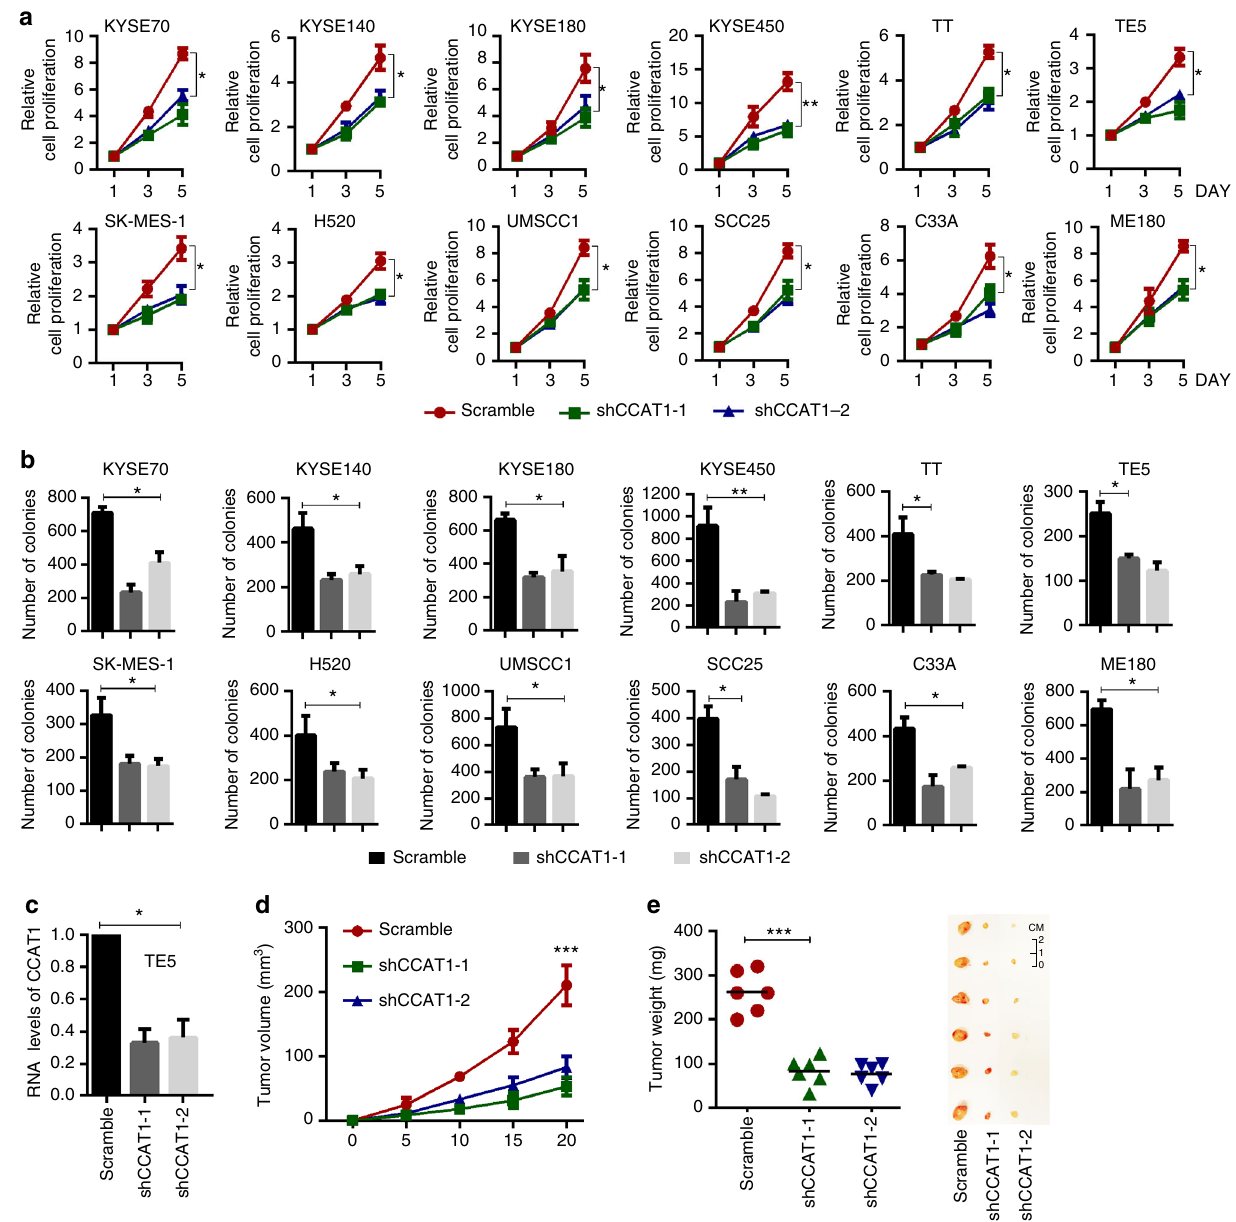
Fig. 3 CCAT1 promotes SCC cell proliferation both in vitro and in vivo. a Cell viability and b Colony formation assays of SCC cell lines upon CCAT1 knockdown with two different shRNA targets. c Relative expression of CCAT1 following silencing of CCAT1 in TE5 cells. Bars of a – c represent mean ± SD of three experimental replicates. * P < 0.05, ** P < 0.01. P values were determined using t -test. d Tumor volumes were measured at the indicated time points in scramble and CCAT1 knockdown xenograft mice. e Left: summary of mean tumor weight measured at end point; Right: images of dissected tumors. N = 6. *** P < 0.001. P values were determined using t